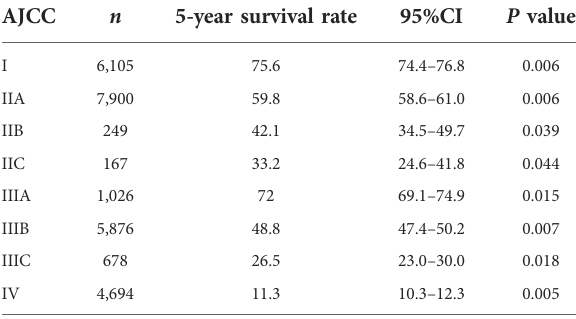
TABLE 2 The 5-year survival rate of CRC patients in the training set from the SEER database based on AJCC staging.